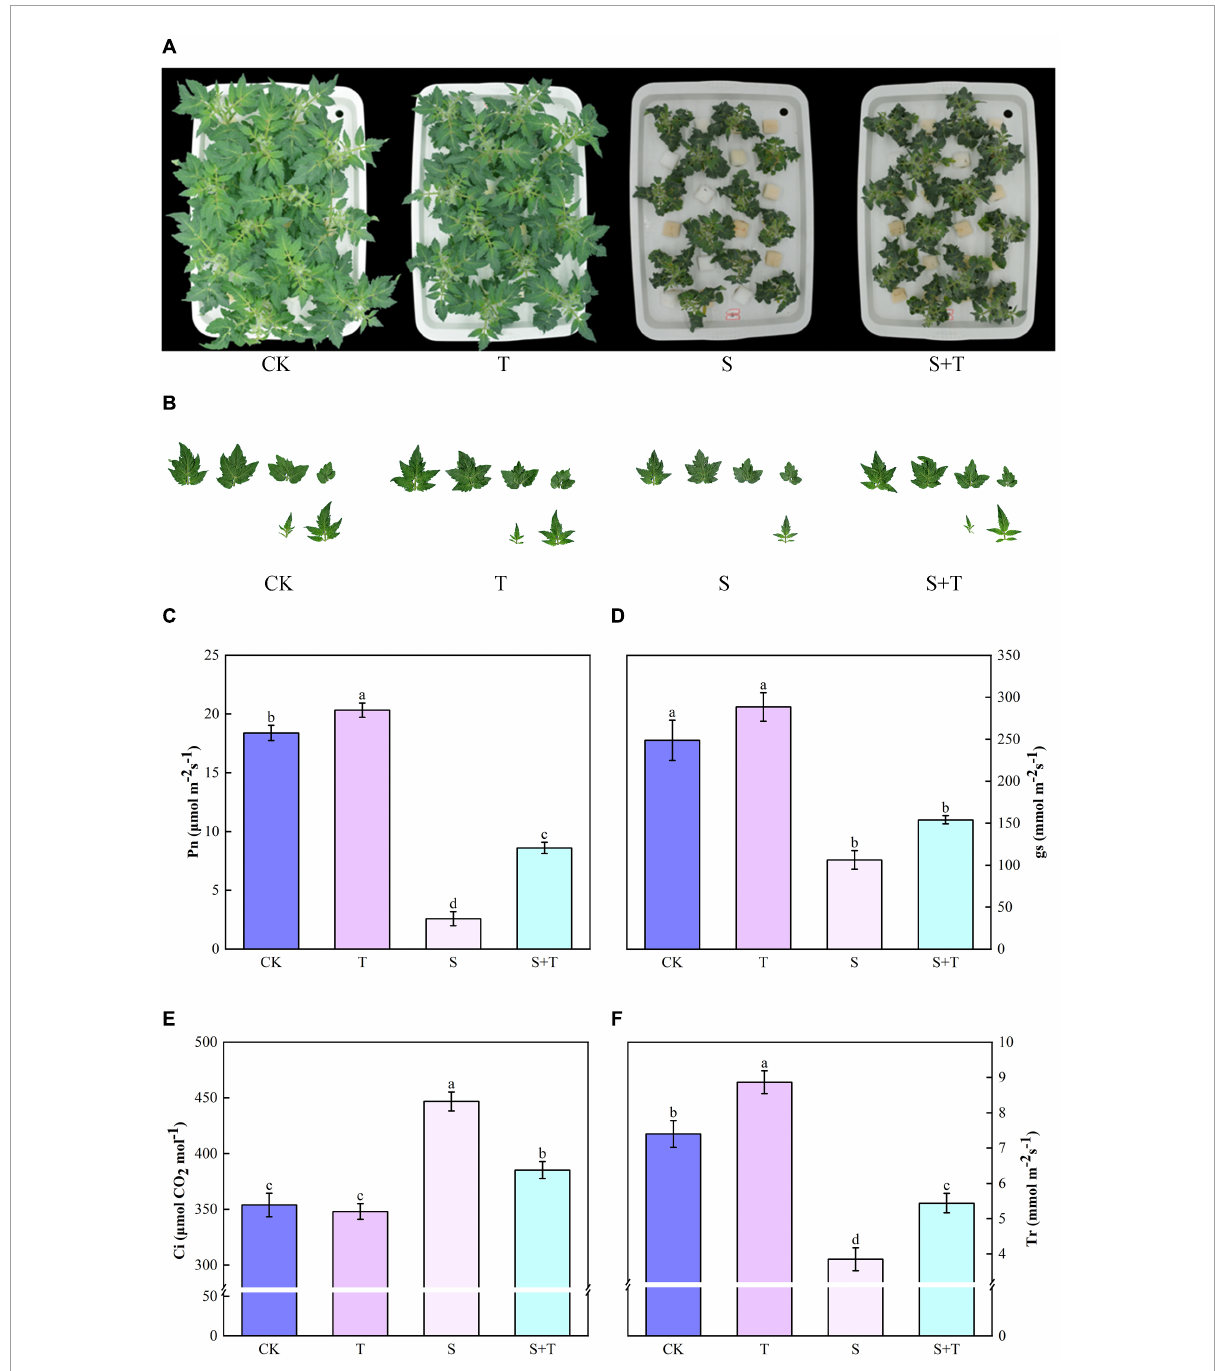
FIGURE1 Effects of Tre treatment on growth attributes and photosynthetic gas exchange parameters of tomato seedlings exposed to salt stress for 5d. (A) Growth attributes. (B) Leaf area. (C) Net photosynthetic rate (Pn). (D) Stomata conductance (gs). (E) Intercellular carbon dioxide concentration (Ci). (F) Transpiration rate (Tr). The results showed the mean ± SE of three replicates, and the different letters denote the significant difference among treatments ( P < 0.05), according to Duncan’s multiple tests. CK, control; T, 10 mM Tre; S, 150 mM NaCl; S+T, 150 mM NaCl + 10 mM Tre.